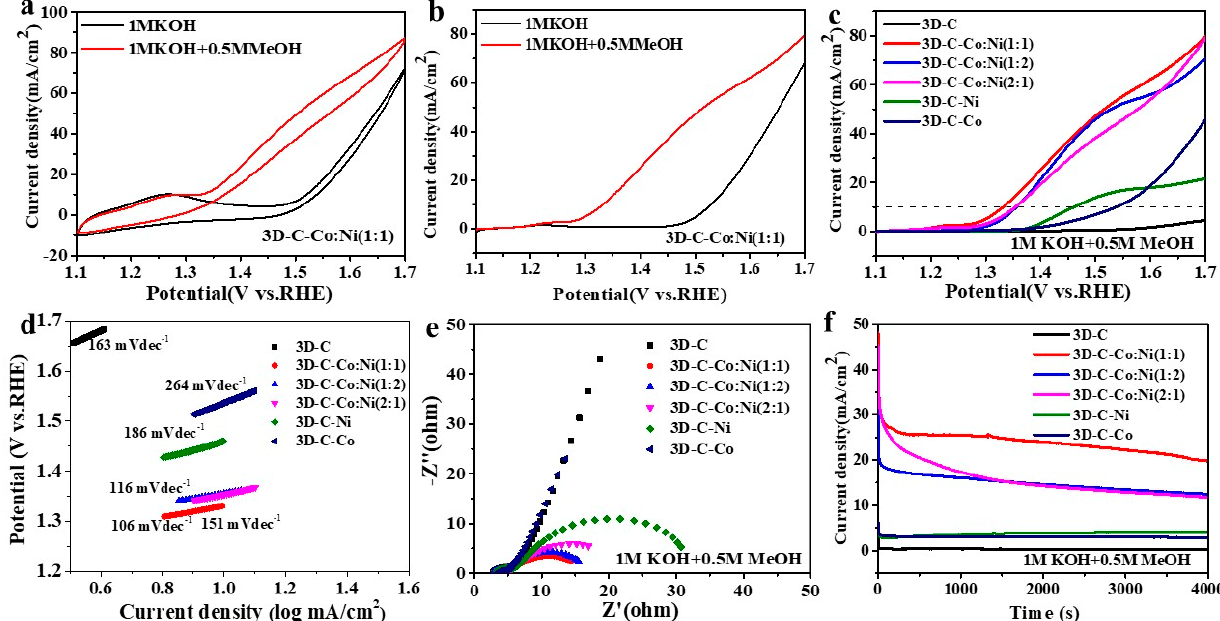
Figure 4. ( a ) CV and ( b ) LSV profiles of 3D-C-NiCo (1:1) for MOR with or without MOH, ( c ) LSV profiles for different catalysts, ( d ) the Tafel slope from LSV curves, ( e ) Nyquist plots of different catalysts, and ( f ) the stability test of 3D-C-NiCo (1:1) for MOR.